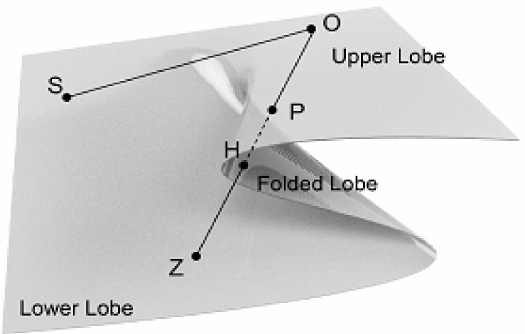
Figure 1. Three-dimensional surface of cusp catastrophe